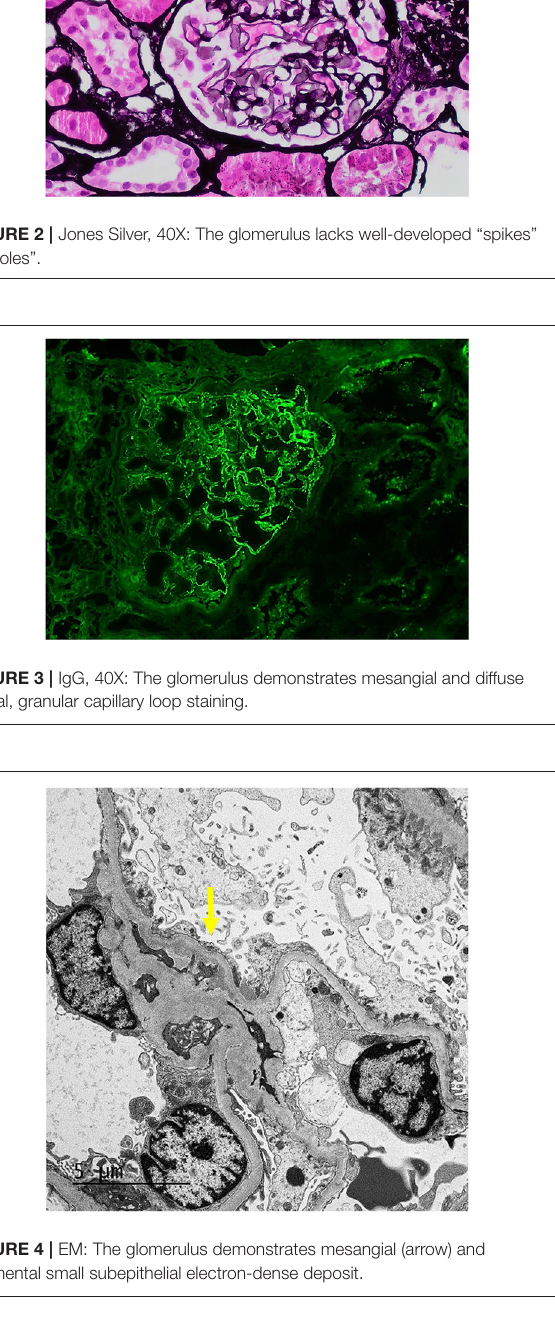
THERAPEUTIC ASSESSMENT